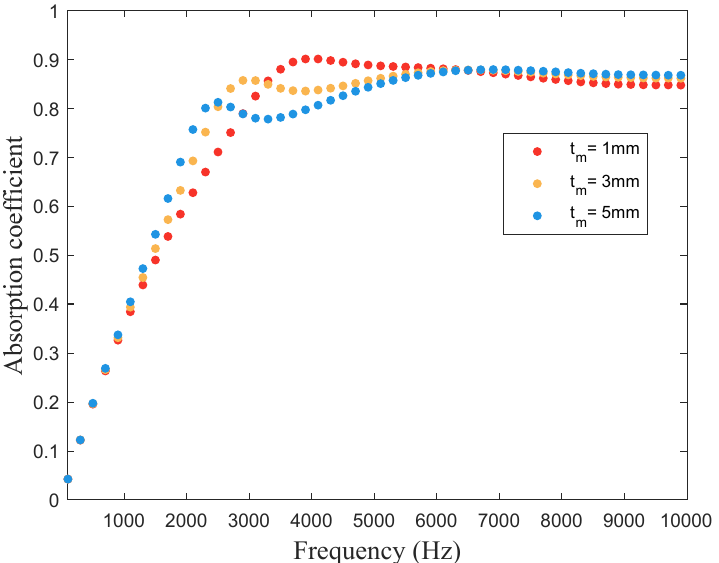
Figure 19. Influence of thickness of the micro perforated plate of the hybrid metastructure on the structure’s sound absorption coefficient.